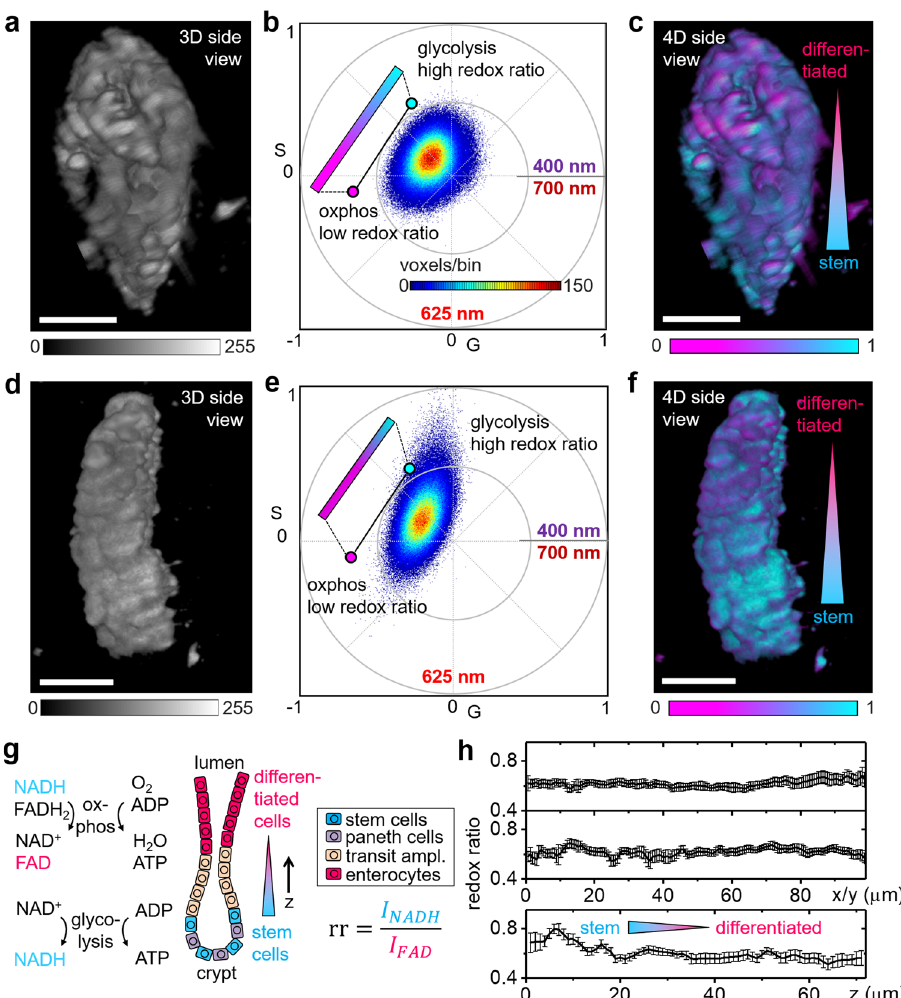
Fig. 6 Metabolic imaging of live mouse tissues. a – f The colon was dissected from a C57BL/6N mouse and embedded in Cultrex Matrix for sine/cosine hyperspectral imaging of NADH and FAD fl uorescence. a , d MIPs of the 3D intensity data obtained by two photon excitation of NADH and FAD fl uorescence with 740-nm light. b , e Spectral phasor plots obtained by collecting though sine/cosine fi lters. c , f MIPs of the 4D hyperspectral data color coded according to the voxel position along the phasor plot trajectory of NADH/FAD. g Molecular pathways for oxidative phosphorylation and glycolysis and schematic of the cellular composition in the intestine and preferred metabolic pathways; the optical redox ratio, rr , is de fi ned as the ratio of NADH and FAD fl uorescence intensities. h Graphs of the optical redox ratios, rr , along the x , y , and z axes of the data visualized in c . Each point represents the average in one yz , xz , and xy plane, error bars indicate standard deviations of the voxel redox ratios in each slice. A gradient in metabolic activity was found in axial direction. Representative images of fi ve different crypts from two different animals imaged on two different days. Scale bars, 50 µ